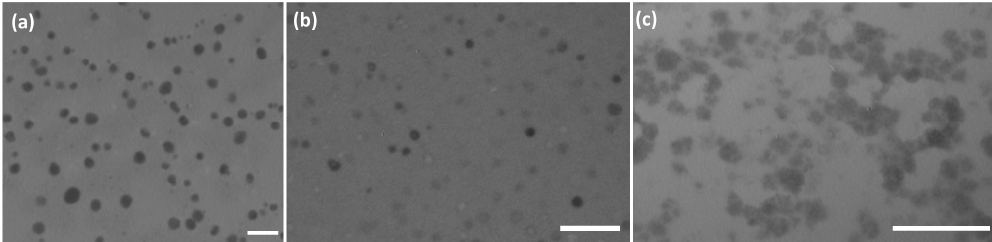
Figure 11. TEM images of polymer-oligonucleotide complexes. The sample compositions corresponds to complexes in line 7 (( a ), P11 polymer), line 11 (( b ), P12), and 19 (( c ), P23) from Table 3. Scale bar represents 200 ( a , b ), and 100 ( c ) nm.